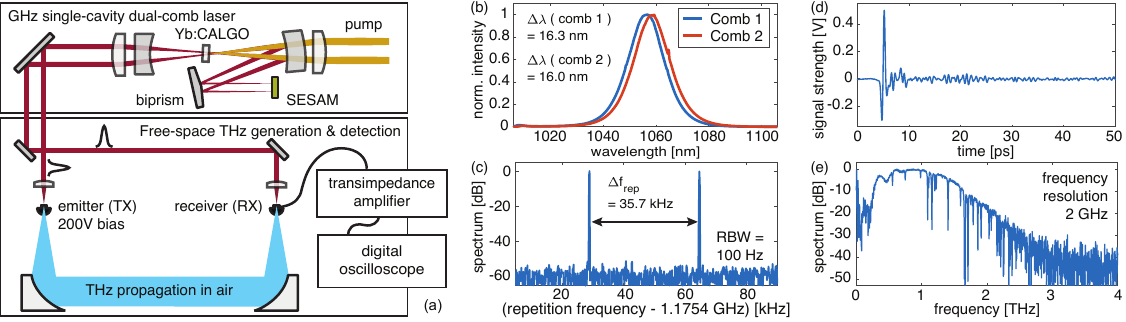
Fig. 1 Experimental setup (a) with single-cavity spatially multiplexed GHz dual-comb oscillator and free-space THz generation and detection. (b) Optical spectrum of the two combs. (c) Microwave spectrum of the two combs around the repetition rate of 1.175 GHz. (d) Averaged THz-signal time trace with a total integration time of 2 seconds. (e) Corresponding THz-spectrum with a frequency resolution of 2 GHz obtained from (d) via a 500-ps apodization window and Fourier transform. Laser results: The dual-comb oscillator is shown in Fig. 1(a). Spatial multiplexing of the cavity is achieved with a biprism, yielding separate spots on the active elements (gain and SESAM). Additionally, the separation of the beams on the biprism allows continuous tuning of the repetition rate difference D f rep in a range larger than [-100, 100] kHz. The laser is pumped by a 980-nm diode delivering up to 900 mW of power from a single-mode fiber. The pump power is split equally and focused onto two spots in the Yb:CALGO gain crystal. Both combs show robust self-starting SESAM modelocking over a wide power range (from 60 mW to 100 mW average power per comb). They have a similar optical spectrum (Fig. 1 (b)) with a FWHM bandwidth >16 nm at a